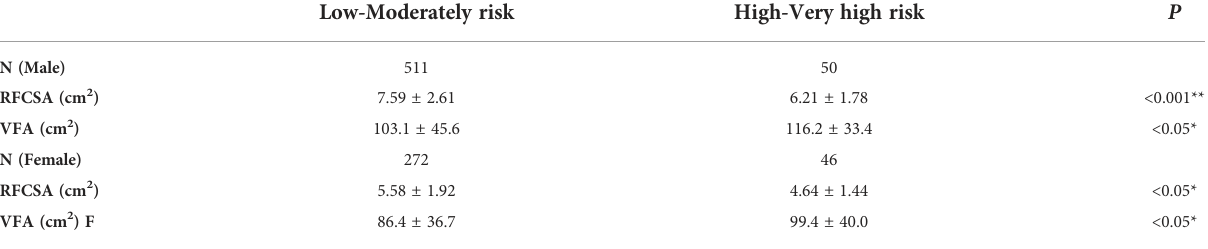
TABLE 2 RFCSA and VFA of T2DM patients with different prognosis risk of DKD. Low-Moderately risk High-Very high risk